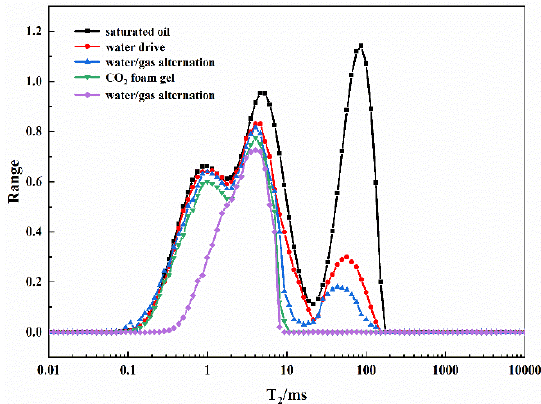
Figure 12. NMR T 2 spectra of different flow control systems in core No. 5.